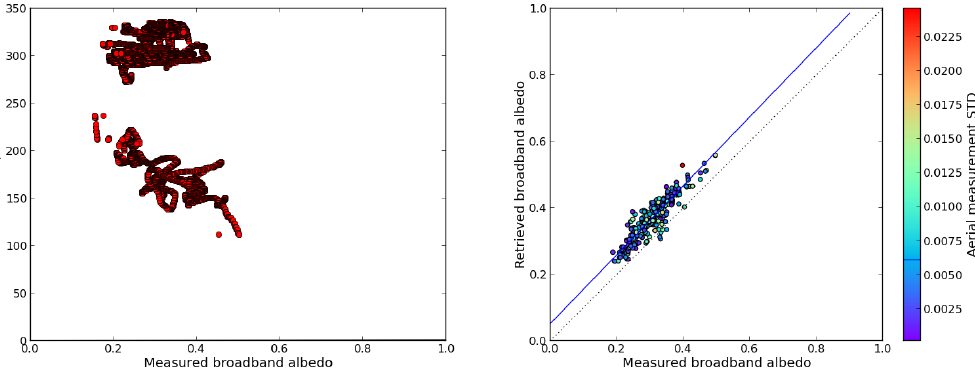
Figure 5. Altitude of the airborne broadband albedo measurements on 6 June 2008, MELTEX campaign (left panel). Correlation between retrieved broadband albedo from satellite data and measured broadband albedo over landfast ice (no drift) (flight track shown on the top panel of Fig. 3). STD is calculated from all collocated aerial measurements for a given satellite pixel. Only pixels with STD smaller than the mean STD are used. N = 169, R = 0.84, RMS (root mean square) = 0.068.